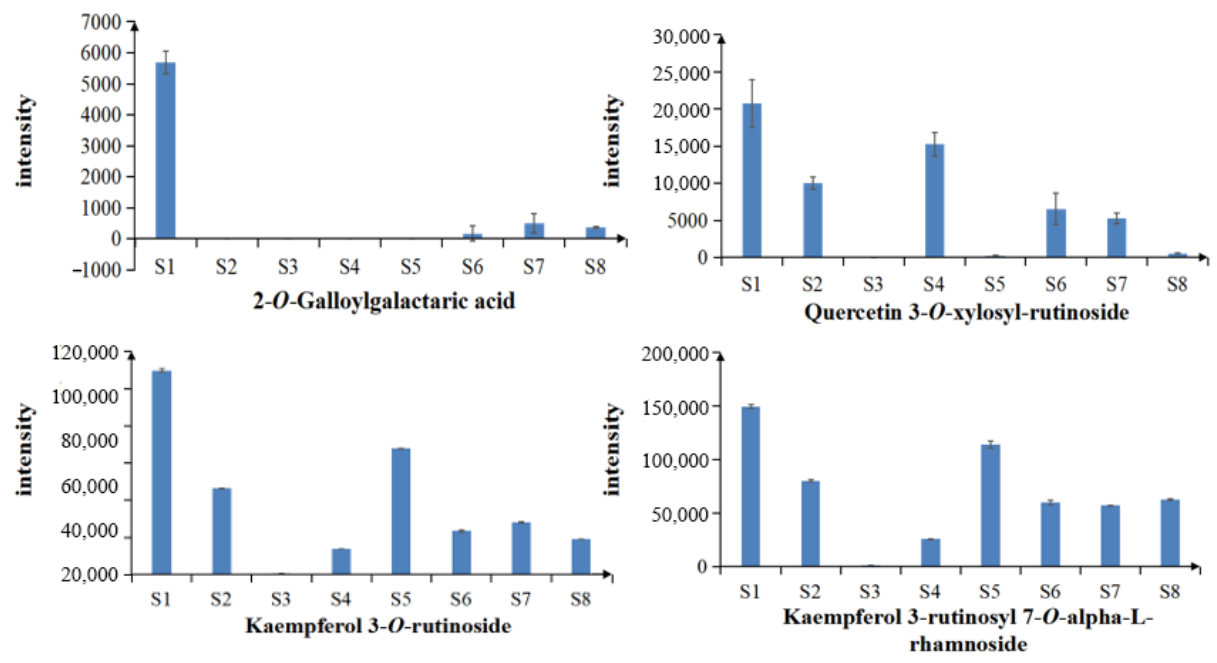
Figure 11. Relative contents of the common differential chemical constituents.